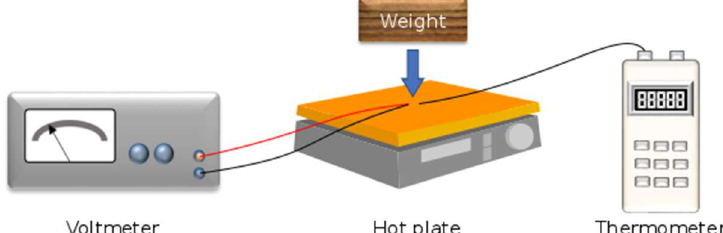
Figure 3. Illustration of the voltage measurement set up. The junction was placed on the hot plate that had been covered with a piece of paper and a wood weight was placed on the junction and thermometer probe.